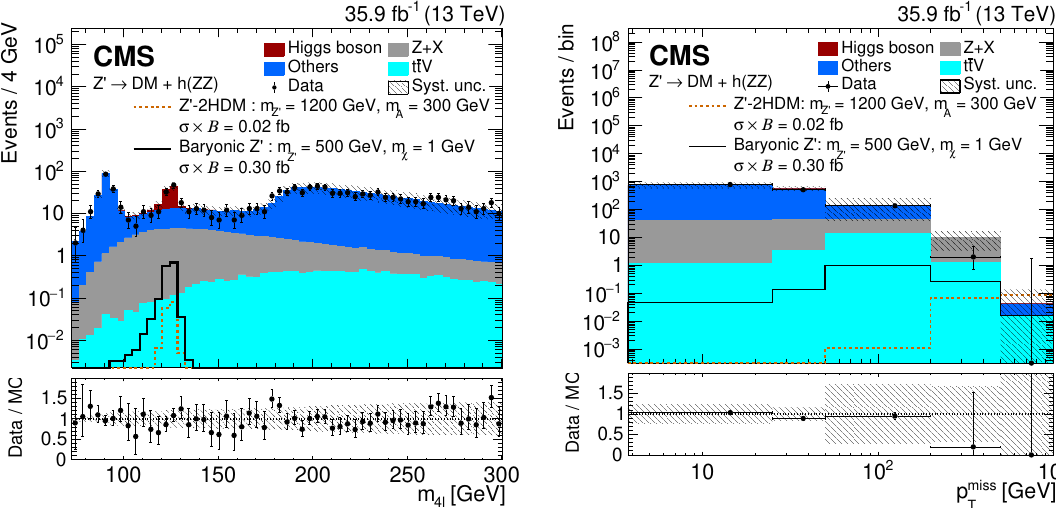
Figure 4 . The four-lepton invariant mass (left) and p miss distributions (right) after the preselection, T expected from MC simulation (stacked histograms) and observed in data (points with vertical bars). The systematic uncertainties, discussed in section 7.1, are shown by the hatched region. Two signal benchmarks, corresponding to the Z 0 -2HDM (dotted orange line) and baryonic Z 0 (solid black line) model are superimposed. The signal is normalized to the product of cross section and , where B represents the h ZZ branching fraction. The lower panel shows the ratio of the data to the B ! predicted SM